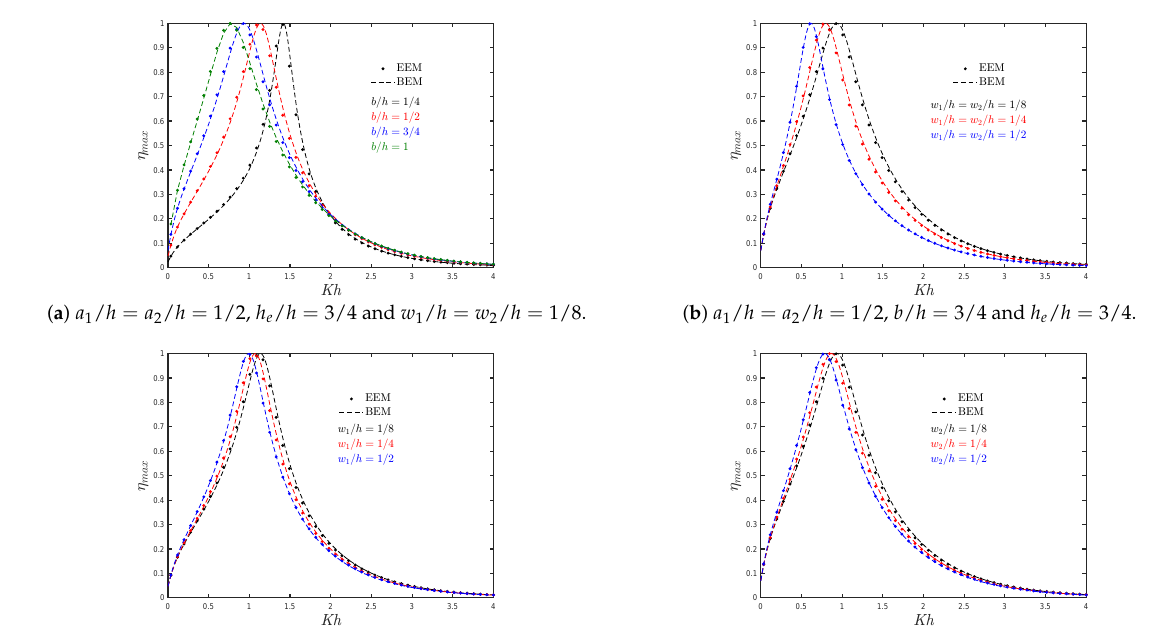
Figure 8. Maximum hydrodynamic efficiency η max versus the non-dimensional frequency Kh for different ( a ) lengths of the OWC chamber b / h ; ( b ) thickness of the rear and front walls, w 1 / h and w 2 / h , respectively; ( c ) thickness of the rear wall w 1 / h ; ( d ) thickness of the front wall w 2 / h